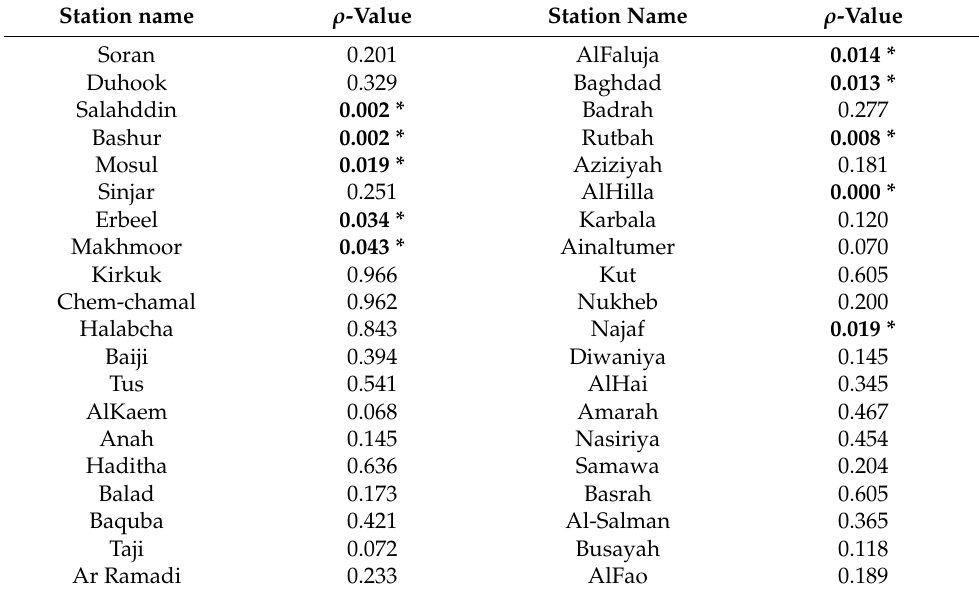
Table 2. Results of the Shapiro–Wilk normality test for the Iraqi weather stations. Station